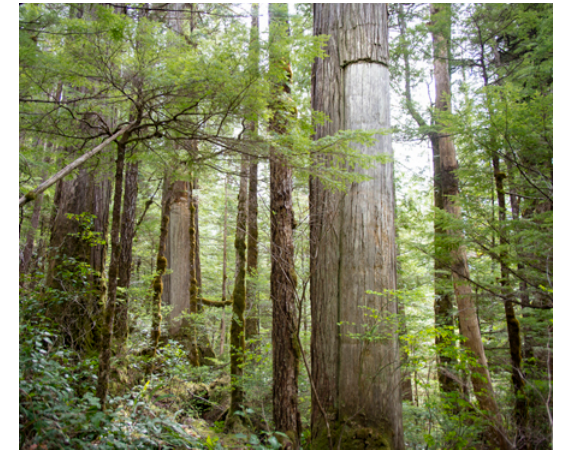
Fig. 2 . Two healing culturally modified western redcedar ( Thuja plicata ) trees in Kitasoo/Xai’xais Territory with large rectangular bark strip